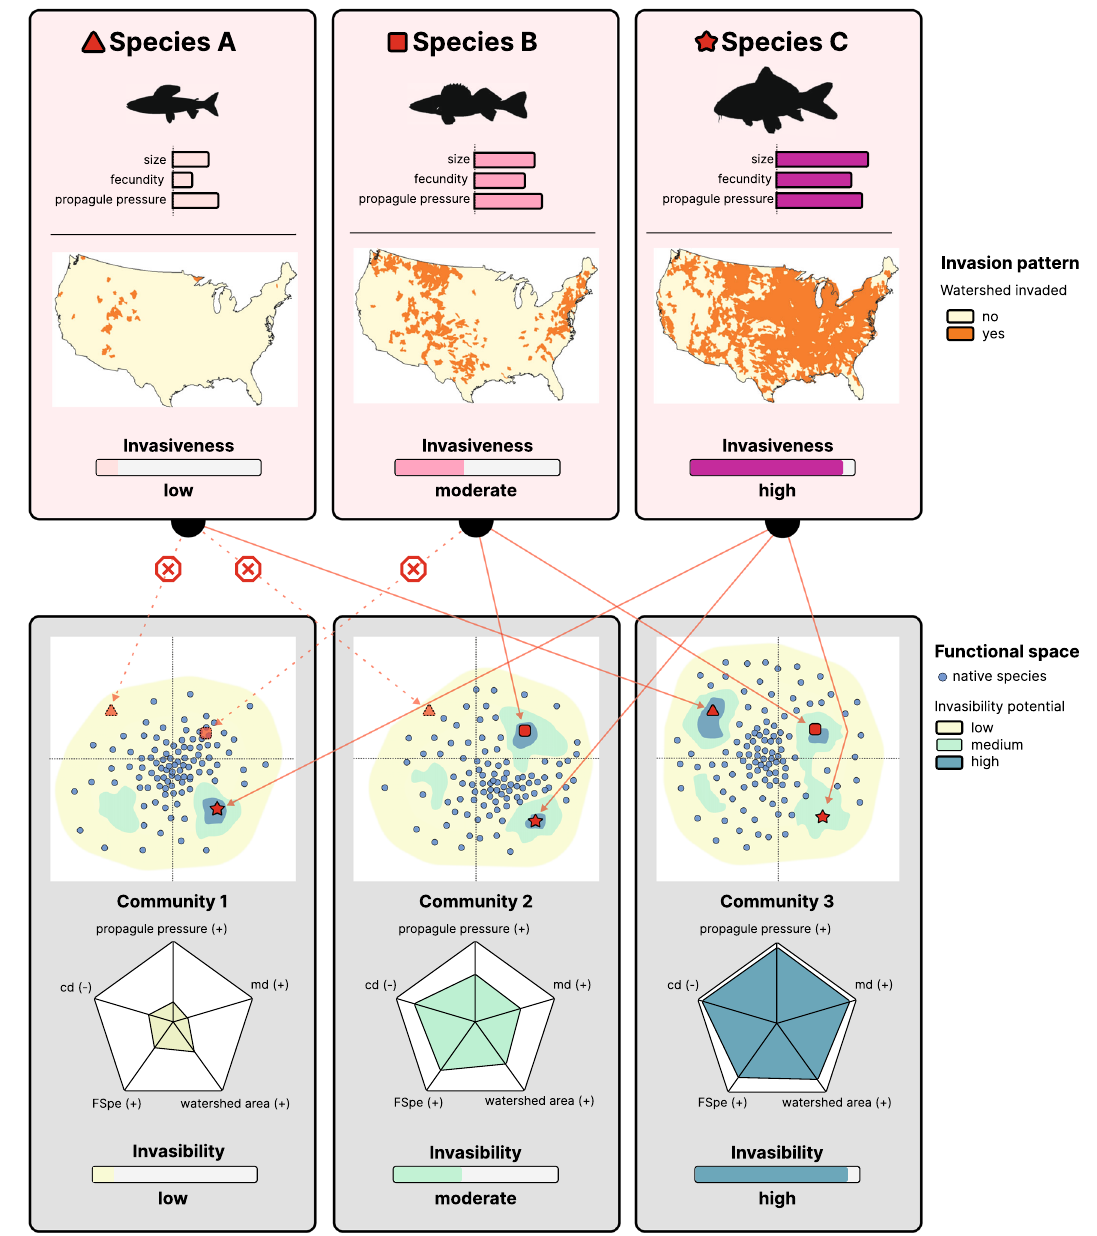
Fig. 5 | Theoretical representation of the links between the non-native fi sh species invasiveness and recipient community invasibility. Non-native species are characterized by traits promoting invasiveness and by human use for each speciesasa proxyfor propagule pressure. Combining speciestraitsand propagule pressure predicts species invasiveness measured as the number of watersheds where the species established (shown in orange on the maps). Species A, B and C thus have a low, moderate and high invasiveness, respectively. Meanwhile, species Calsohasahighchancetoestablishinthethreerecipientcommunitiesbecauseits functionaltraitslocatethespeciesclosetothecenterofthefunctionalspaceofthe recipient communities (i.e., low centroid distance between non-native species and native assemblage) and the non-native species traits are not redundant with those